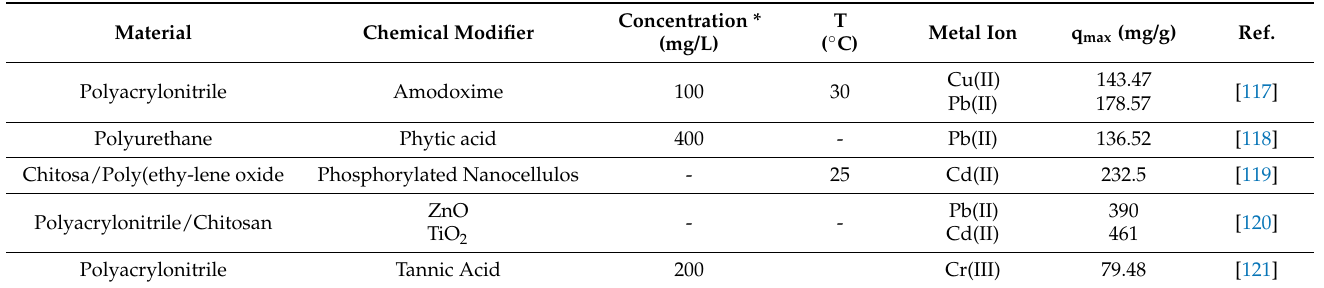
Table 13. Heavy metal adsorption by using polymer electrospun nanofiber